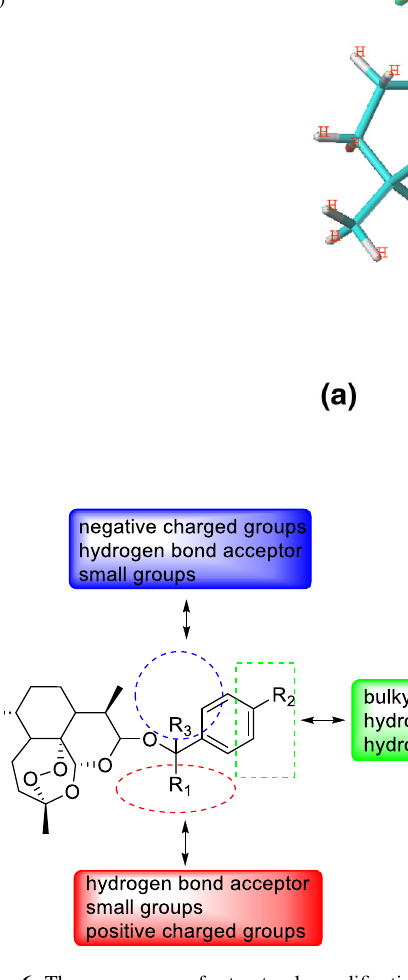
Fig. 6 The summary of structural modification for artemisinin derivatives from the QSAR